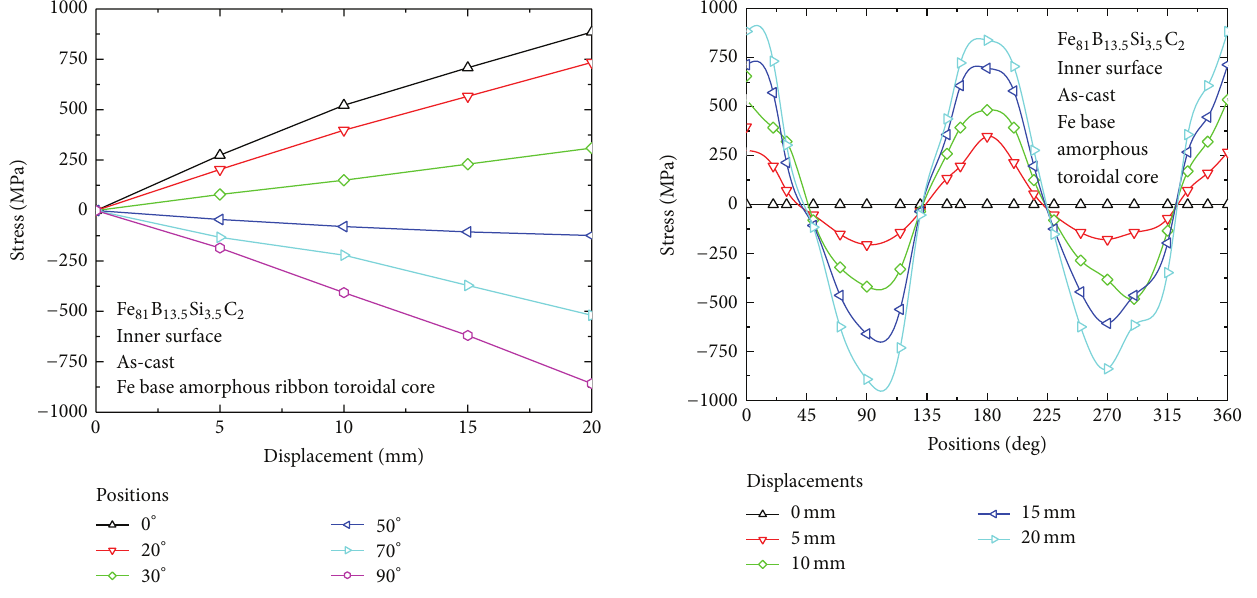
differences in the magnitude of the induced stress, between the two halves, the stress distribution was similar; there were tensile stresses at the 180 ∘ and 360 ∘ positions of approximately +800 MPa, for full displacement of 20 mm.